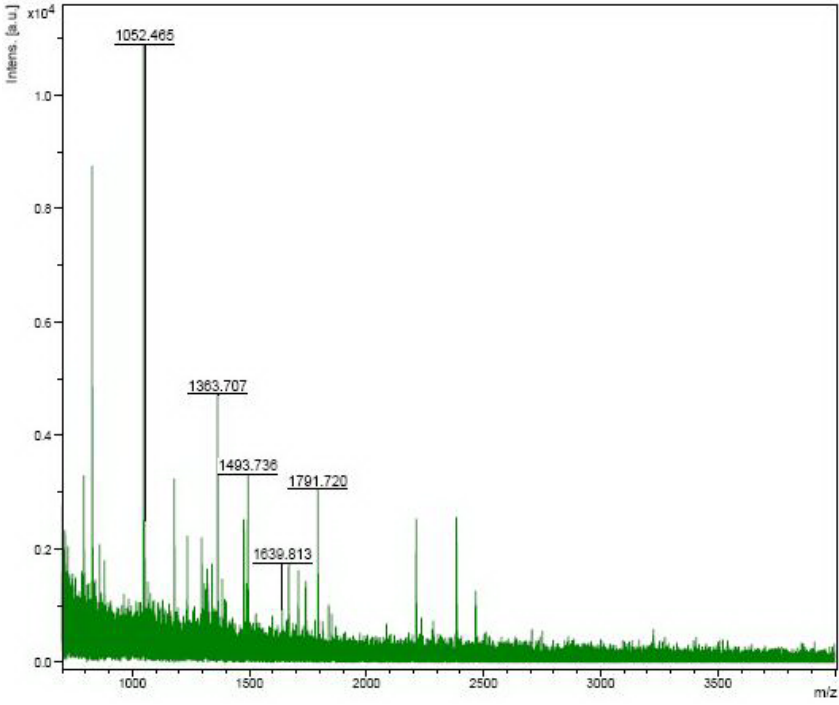
Figure 2. Results of HSP90 as the representative protein identified using MALDI-TOF-MS.